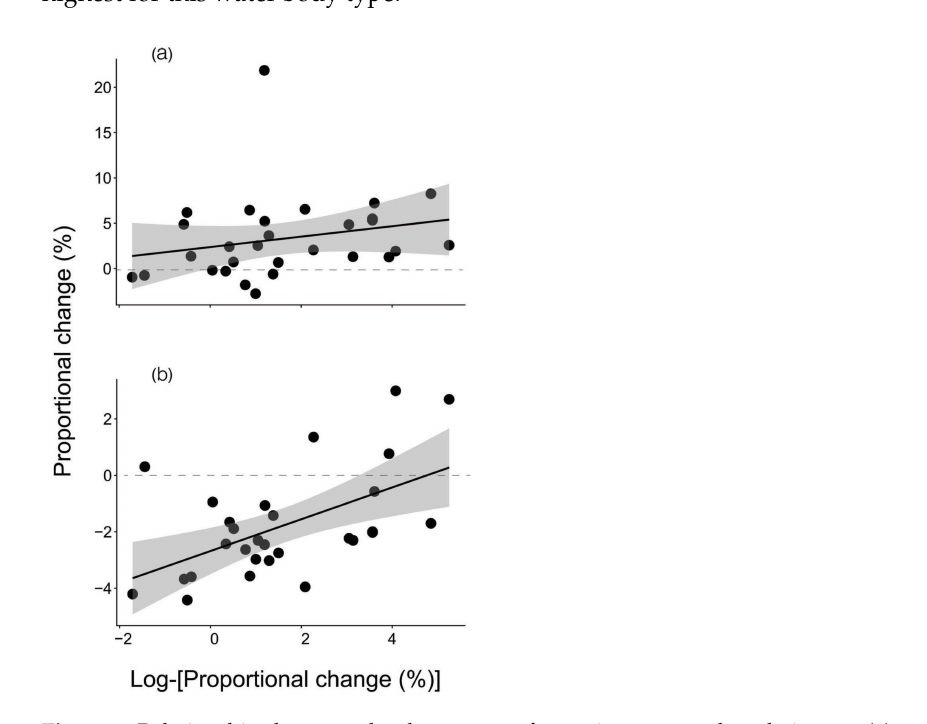
Figure 6. Relationships between the change rate of organic matter and total nitrogen ( a ) and between the change rate of organic matter and total phosphorus ( b ). In both panes, the change rate of organic matter is plotted on a horizontal axis. Regression line and 95% confidence intervals were also shown.